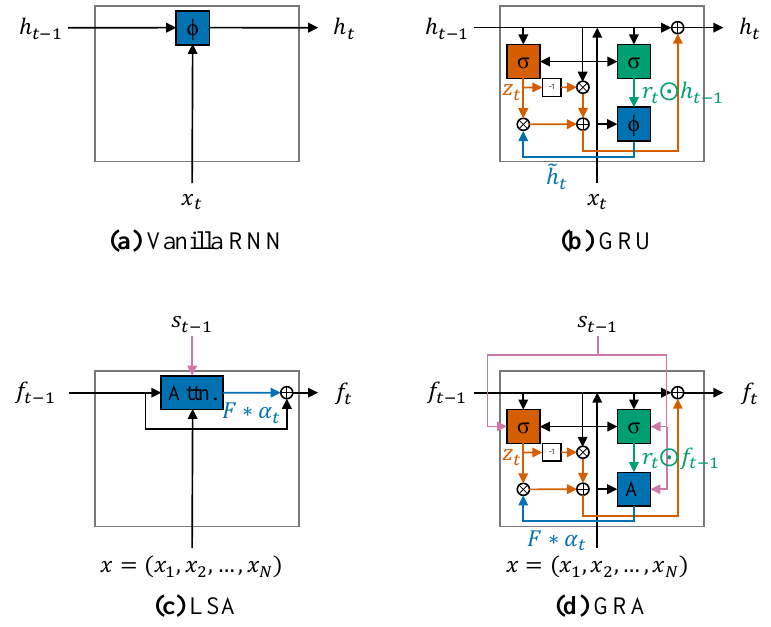
Figure 2. Illustration of recurrences in ( a ) Vanilla recurrent neural network (RNN), ( b ) Gated recurrent unit (GRU), ( c ) Location-sensitive attention (LSA), and ( d ) Gated recurrent attention